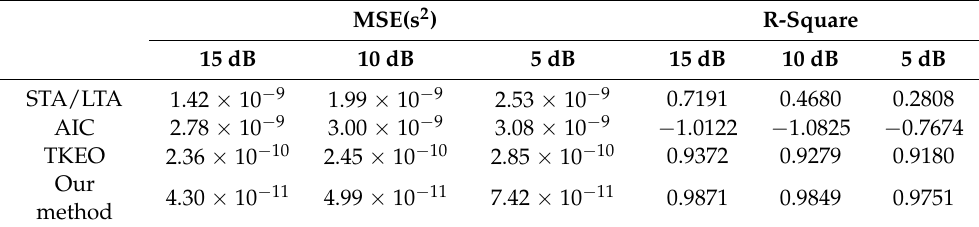
Table 1. Mean Square Error and R-square determined by the four